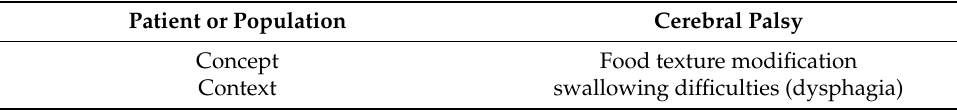
Table 1. The Population, Concept, and Context (PCC) Table.